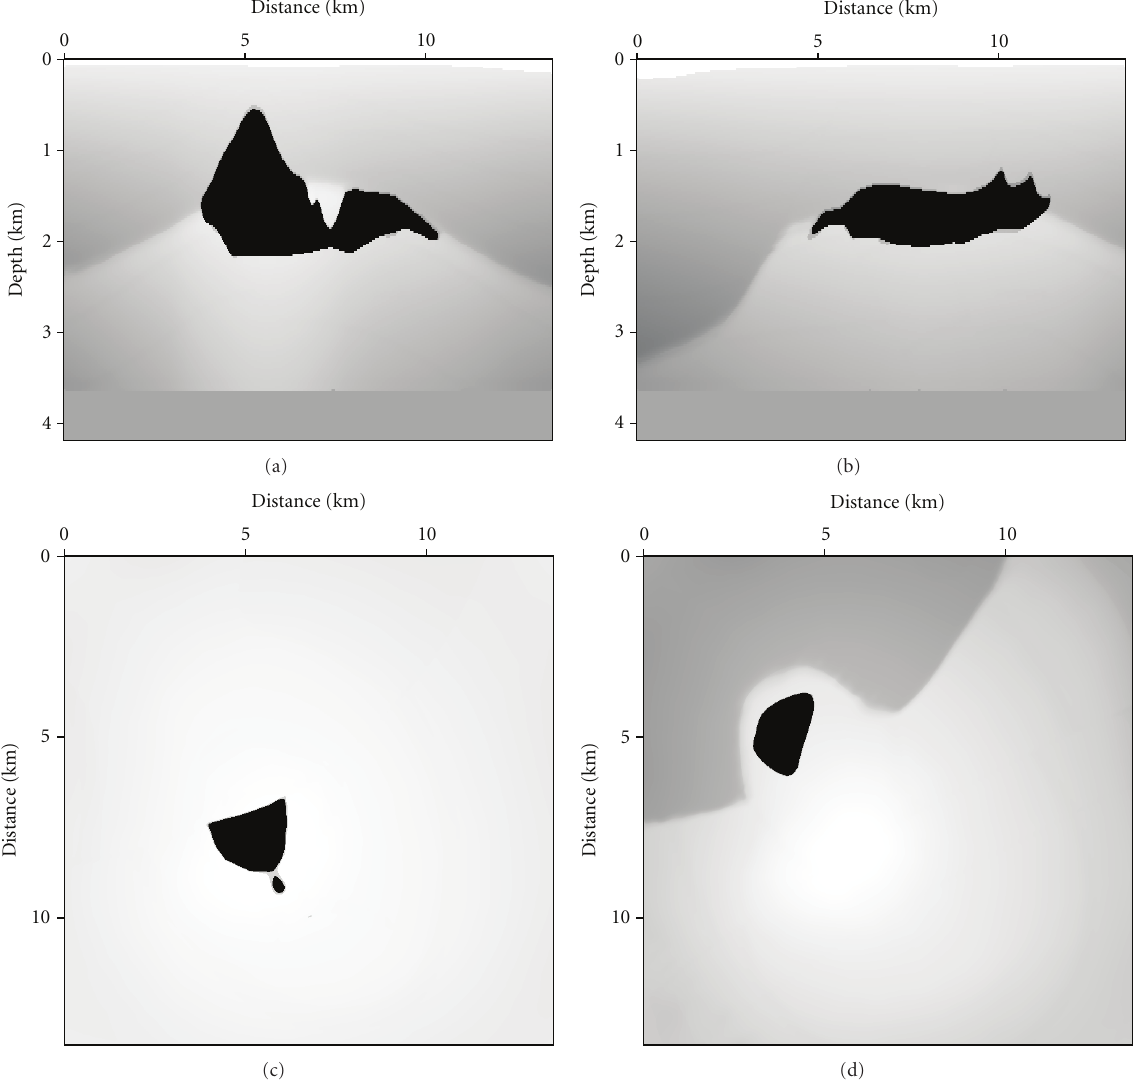
Figure 1: Two horizontal and two vertical cross-sections across the EAGE/SEG salt model at x = 8 . 32km (a), y = 8 . 32km (b), z = 1 . 1km (c) and z = 2 . 7km